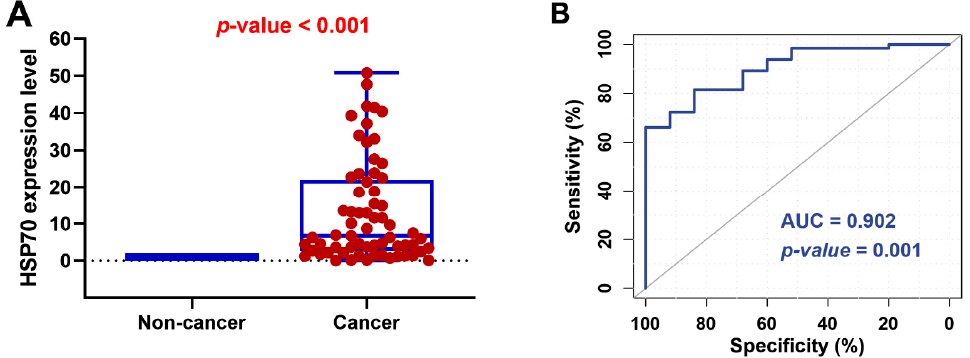
Figure 2. HSP70 gene expression profile. ( A ) Expression in non-cancerous and cancerous renal tissue of renal cell carcinoma (RCC). Data are represented as medians. The box defines upper and lower quartiles (25% and 75%, resp.), and the error bars indicate upper and lower adjacent limits. Expression levels of HSP70 were normalized to GAPDH. Fold change was calculated using the delta-delta CT method (2 − ∆∆ CT ) compared to normal renal tissues. The median and quartile values of patients are demonstrated in blue. The dashed line represents the expression level of non-cancerous renal tissues (equivalent to 1.0). The Mann–Whitney U test was used for comparison. ( B ) Receiver operating characteristic curve analysis of HSP70 expression level for discriminating patients with RCC from the non-cancerous group. AUC: area under the curve. p -value < 0.05 was considered statistically significant. HSP70 signature was higher in tumor samples with large sizes ( p < 0.026), advanced pathological grade ( p < 0.001), capsular infiltration ( p < 0.001), RCC recurrence ( p < 0.001), and mortality ( p < 0.001) (Figure 3). Moreover, post-hoc analysis was performed to detect